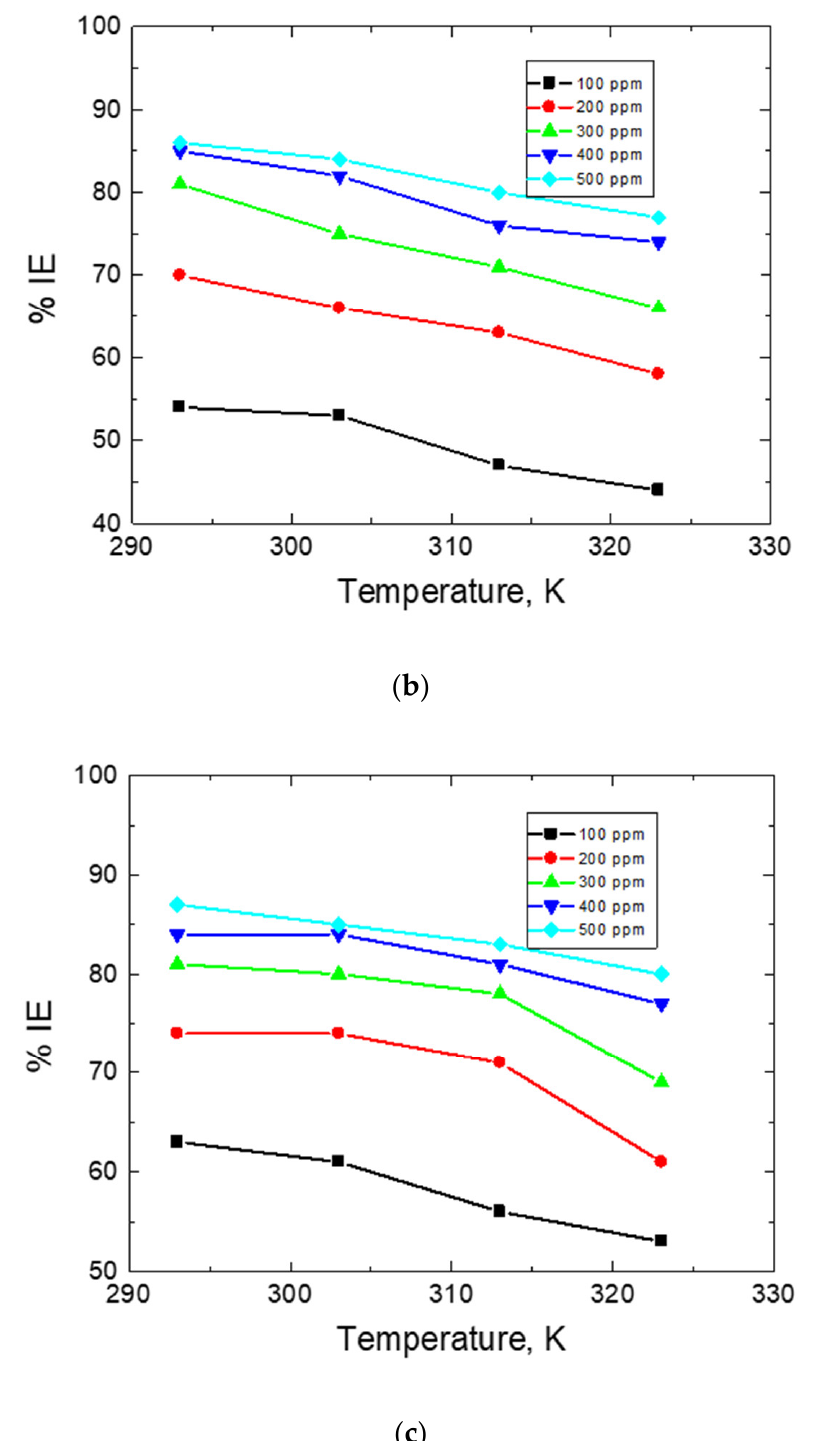
Figure 12. Graphs of the change in %IEs with the temperature in the mild-steel corrosion in 0.5 M HCl comprising various concentrations of the examined carbohydrate polymers. ( a ) Chi, ( b ) Pec, and ( c ) A-Pec.